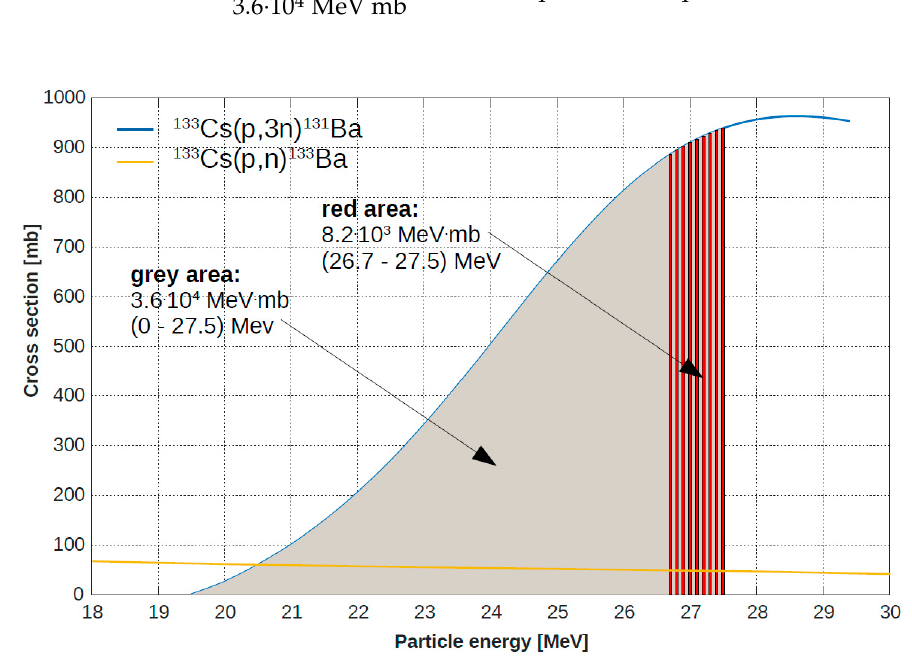
Figure 3. Cross section for the barium-131 production (blue line) and barium-133 (yellow line). An influence of moisture on the target was not observed in the short time between preparation and irradiation. Except darkening in the irradiated area, the pressed cesium salt shows no significant changes after irradiation. The dark color disappears immediately during the addition of nitric acid.